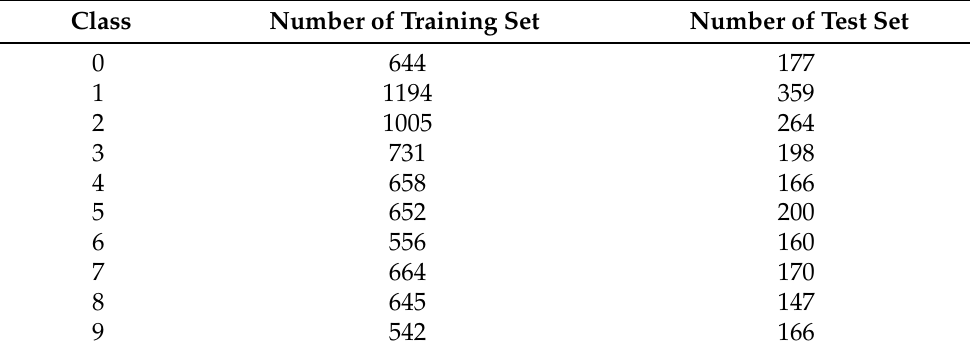
Table 2. Training and test sample numbers of the USPS dataset.